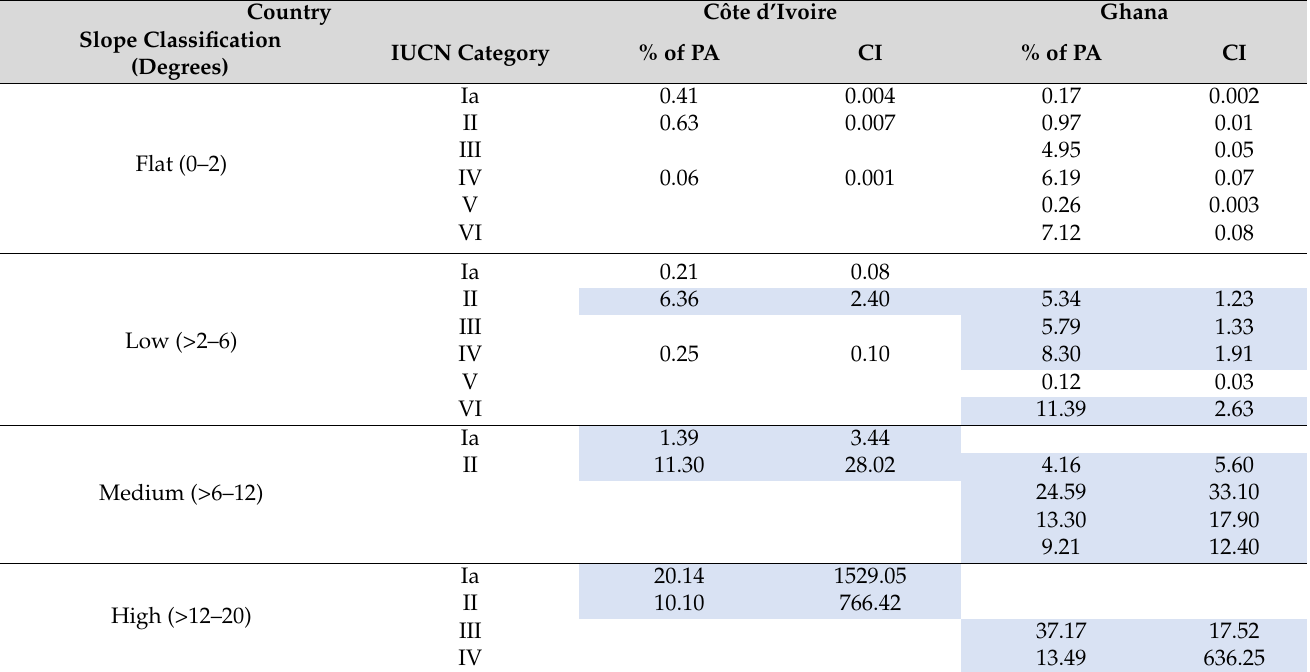
Table 6. The comparison index (CI) for IUCN protected area categories and their percentage land areas of the slope classes in C ô te d’Ivoire and